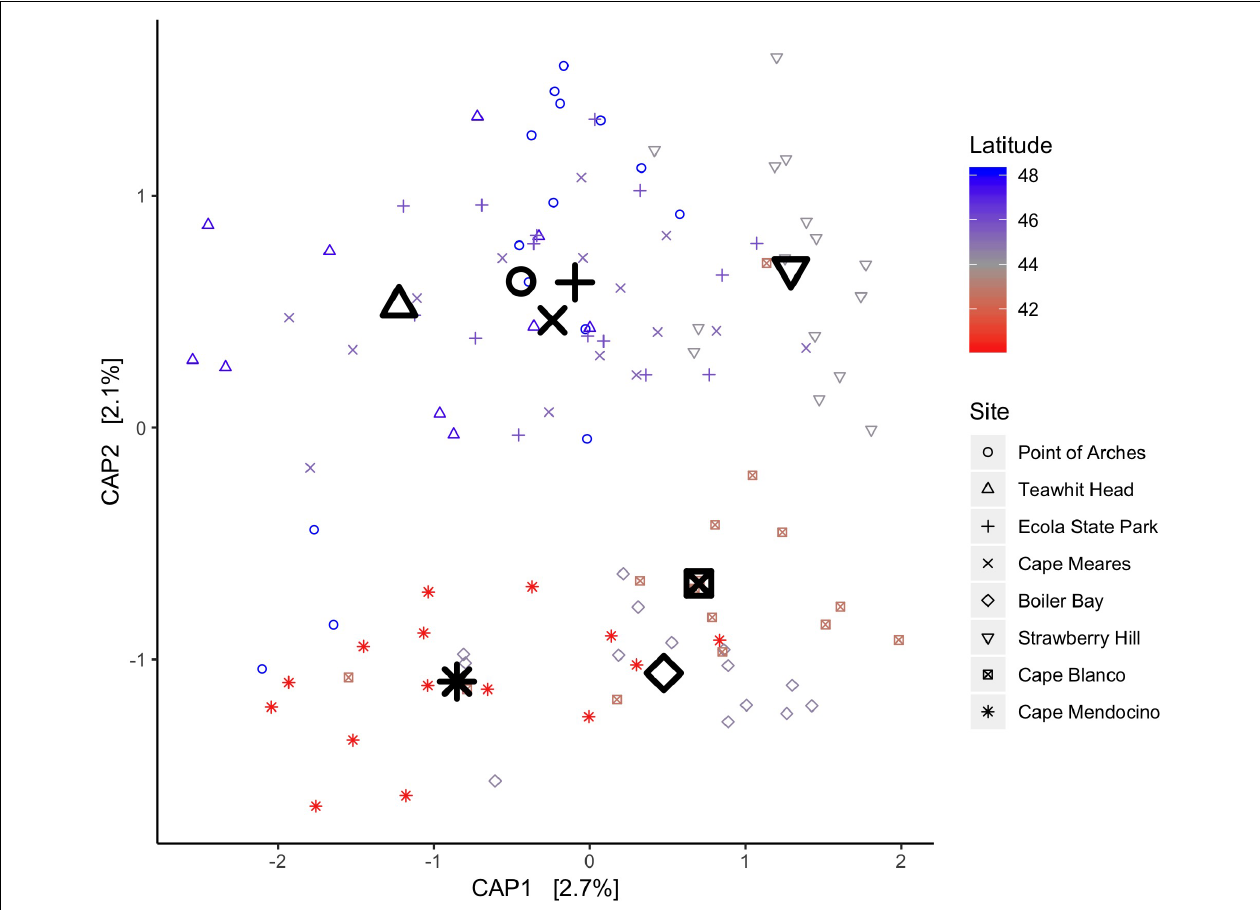
FIGURE 6 | A CAP ordination on Bray-Curtis dissimilarities between A. elegantissima communities across latitudes reveals some structure. Latitude explains a small part of the variance across the range when treated as a quantitative variable ( p = 0.002, R 2 = 0.022). Site labels were placed at the centroids of samples from each